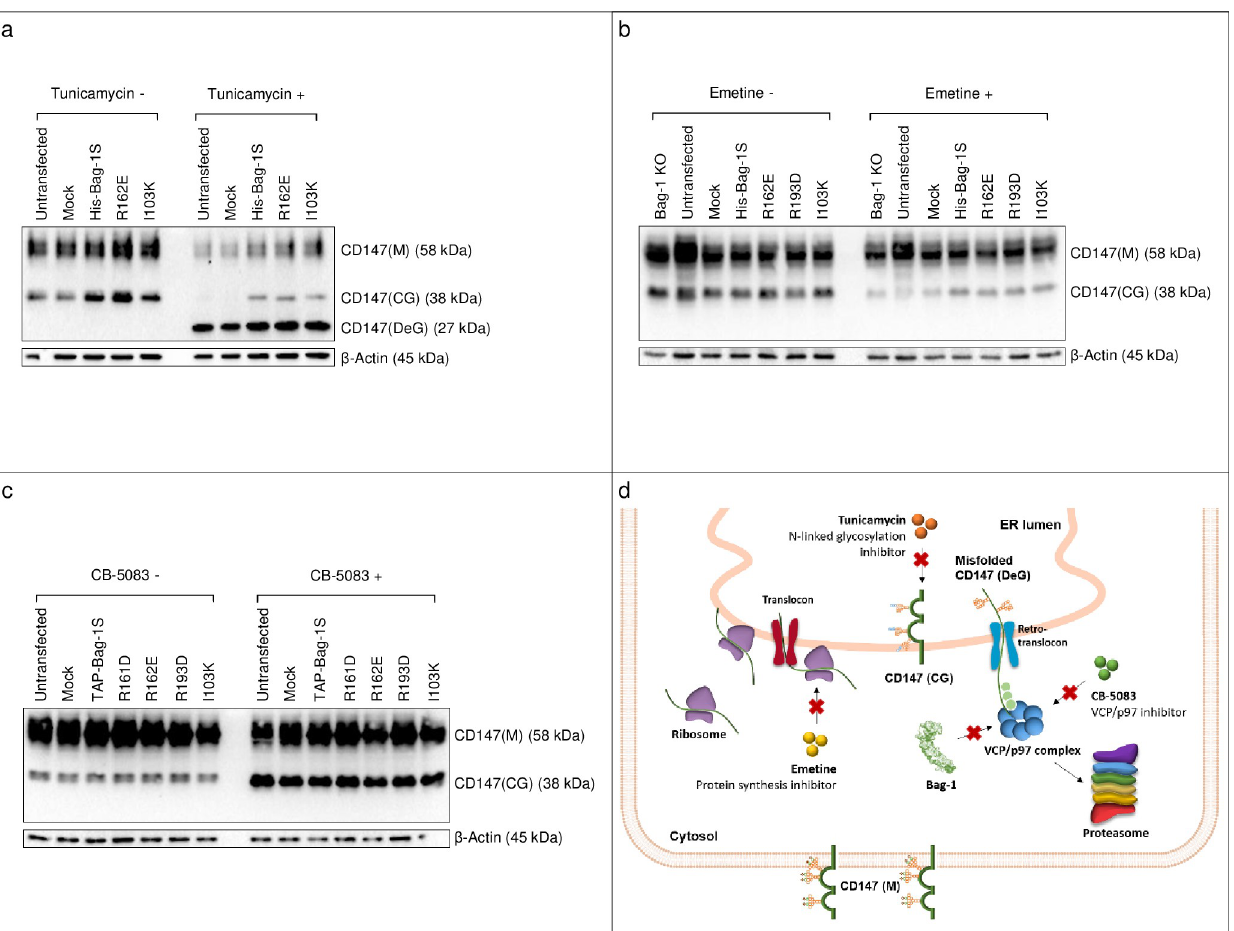
Fig 7. Bag-1 downregulates VCP/p97-dependent ER-associated degradation of CD147. Bag-1 KO MCF-7 cells were transfected with mock vector, wild- type Bag-1S and mutant Bag-1S, and treated with a . glycosylation inhibitor tunicamycin, b . translation inhibitor emetine, c . VCP/p97 inhibitor CB-5083. Immunoblots of CD147 (M: Mature, CG: Core glycosylated, DeG: Deglycosylated) are shown in a-c . d . model for downregulation of CD147 degradation by Bag-1.